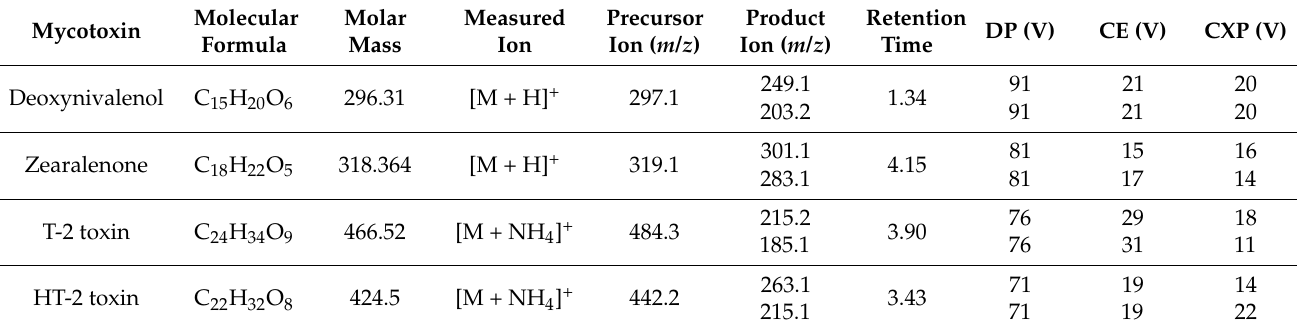
Table 2. MS/MS parameters for the determination of DON, ZEN, T2, and HT2 in oats.